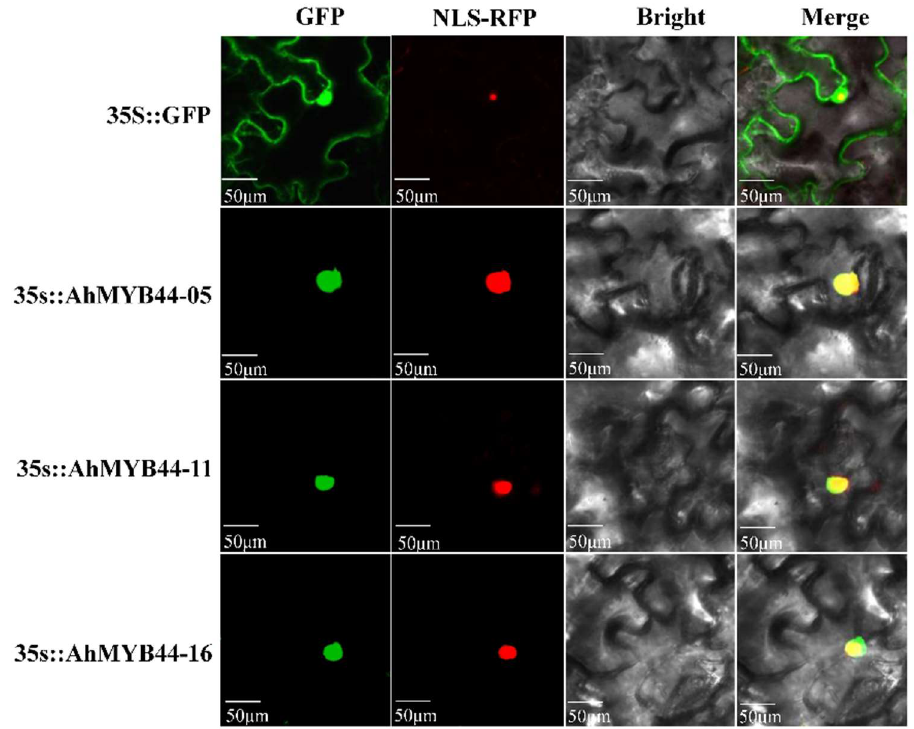
Figure 4. Subcellular localization of AhMYB44s in tobacco leaves. Agrobacterium carrying the 35S:AhMYB44-05/11/16: GFP and 35S: GFP genes were infiltrated into N. benthamiana leaves. Nucleus-localized NLS-RFP fusion protein was used as a nuclear localization marker. Images were obtained using confocal microscopy 2 d after agroinfiltration. Bars = 50 μm.